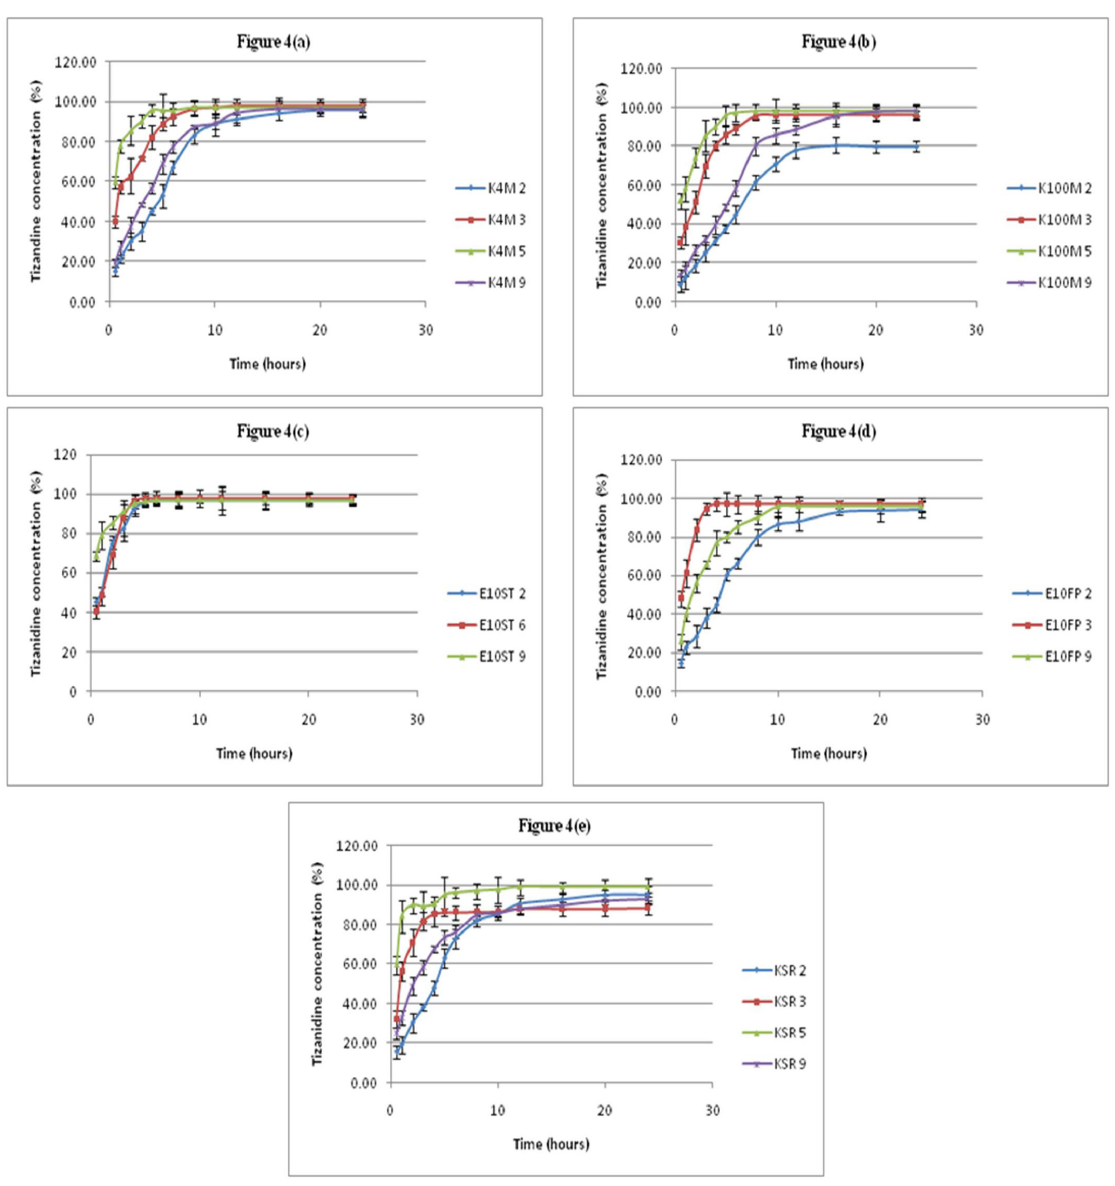
FIGURE 4 - Drug release profiles of tizanidine formulations in phosphate buffer pH 6.8 containing (a) HPMC K4M (b) HPMC K100M (c) Ethocel 10ST (d) Ethocel 10FP (e) Kollidon